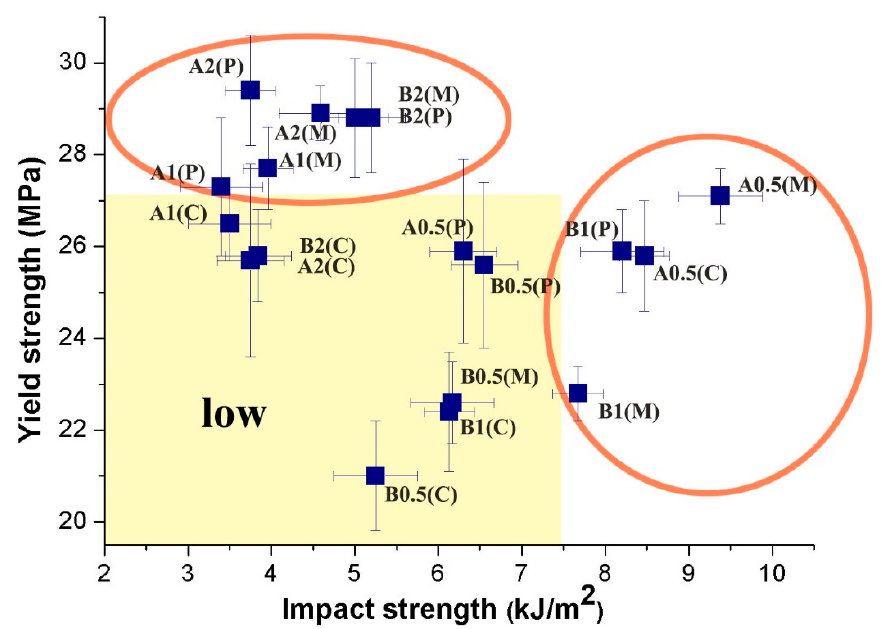
Figure 6. Impact strength versus yield strength. The yellow box represents the samples with low tensile and impact strength, and the high-performance samples are circled.